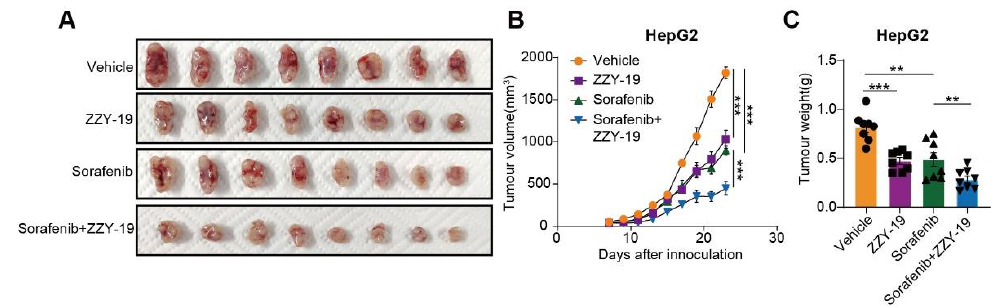
Figure 8. The combination of ZZY-19 with sorafenib synergistically suppresses the progression of HCC in vivo. ( A ) Representative images of tumors in nude mice. The mice were injected subcuta- neously with HepG2 cells ( n = 8). Seven days after injection, the mice were oral gavage with vehicle (Kolliphor ® HS 15, i.g., once a day), sorafenib (30 mg/kg, i.g., once a day), ZZY-19 (30 mg/kg, i.p., once a day), or ZZY-19 plus sorafenib for 14 days. ( B ) Effects of the indicated treatments on tumor growth in HepG2 CDX mouse models. ( C ) Effects of the indicated treatments on tumor weight in HepG2 CDX mouse models. ** p < 0.01; *** p <